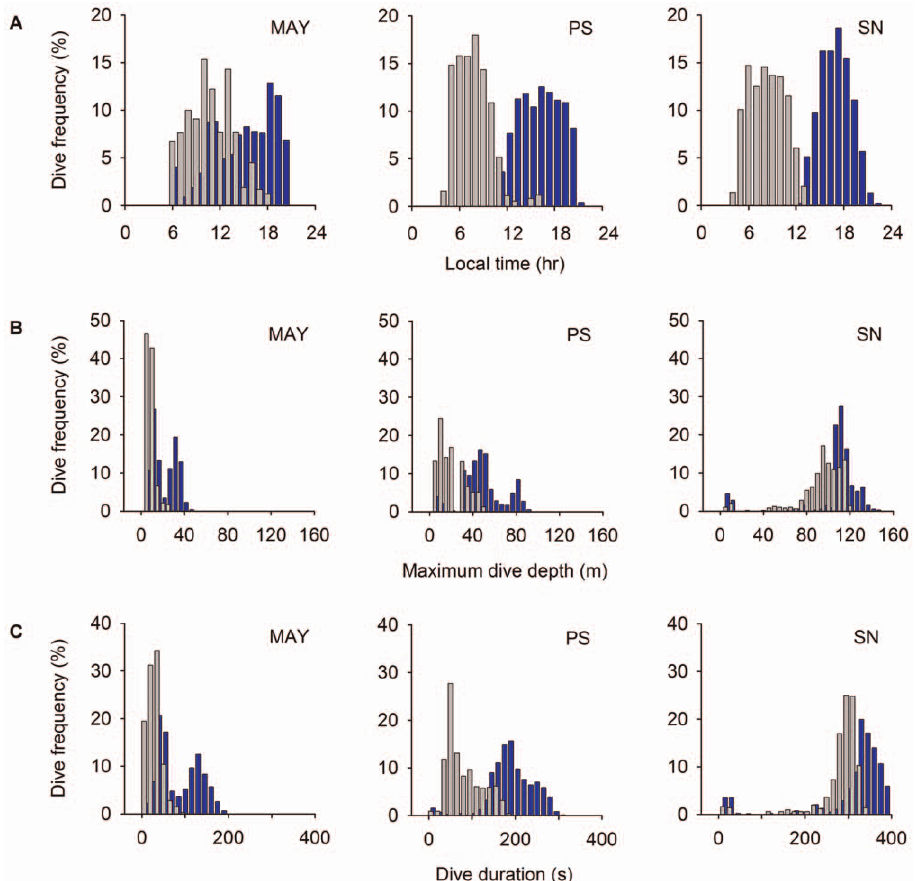
Figure 4. Sexual differences in diving behaviour in the Kerguelen Shag. Distribution of dives in relation to (A) time of day, (B) maximum dive depth and (C) dive duration. Colonies are Maye`s (MAY), Pointe Suzanne (PS) and Sourcils Noirs (SN). Females are in grey, males in blue.